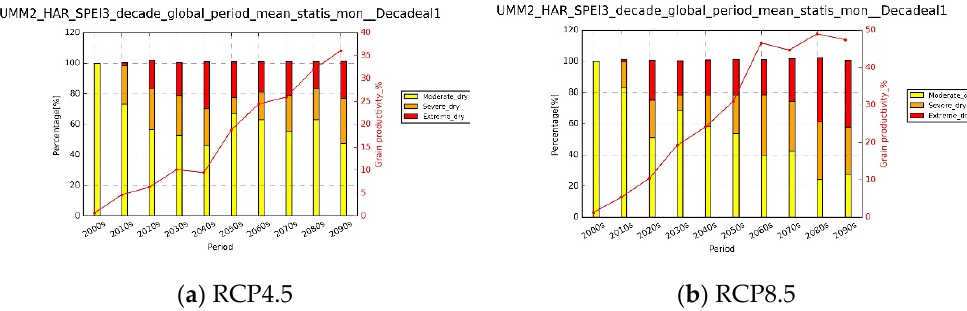
Figure 9. The simulation of farmland potential yield under two RCPs based on CMIP5: the red line (right axis) represents the percentage of potential total agriculture production affected by drought; the bar graph (left axis) represents the percentage of potential production loss caused by different levels of drought.